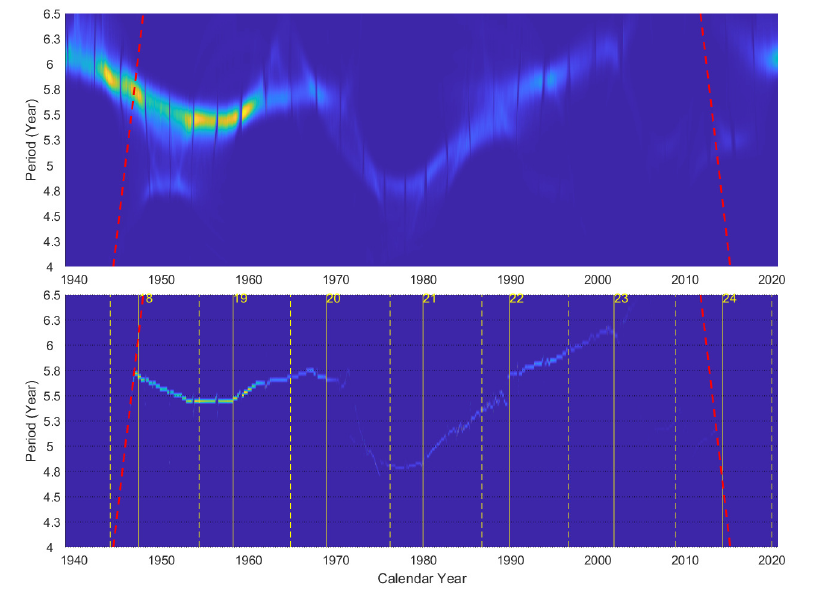
Figure 8. Same as Figure 6, but for periods between 4-yr and 6.5-yr.